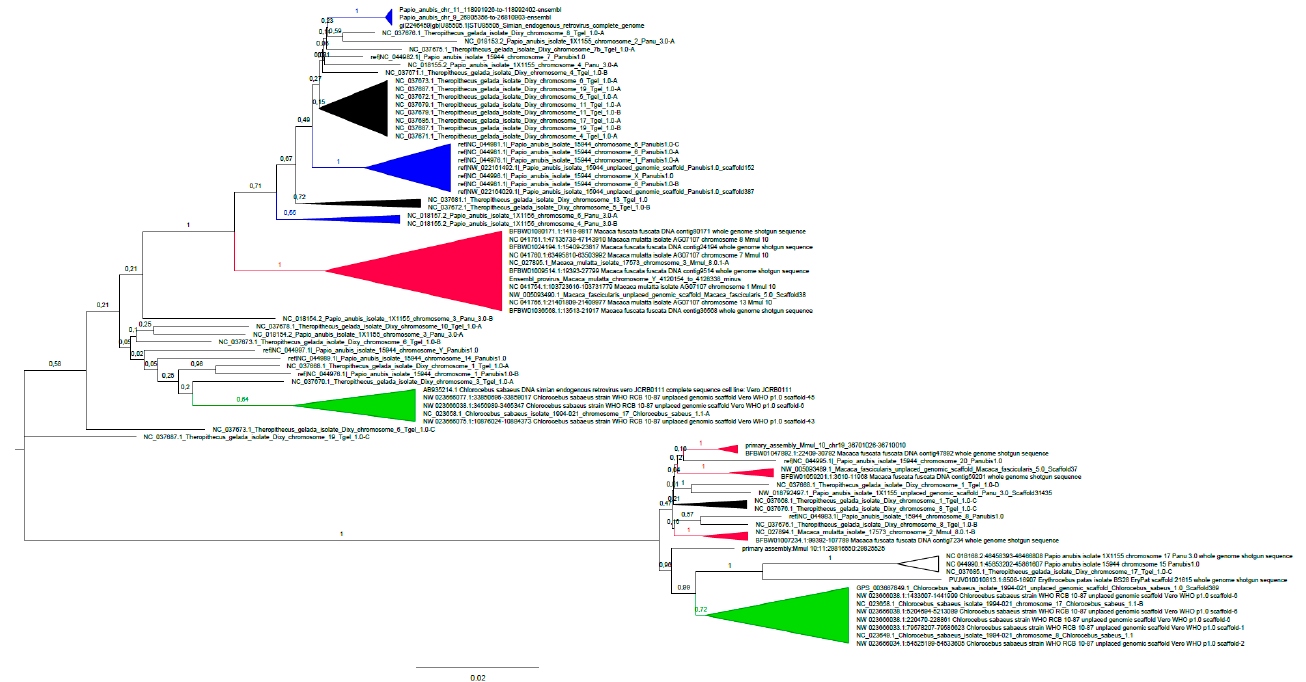
Figure 1. Phylogenetic analysis of 81 full-length Cer-SERV genomes. The evolutionary history was inferred by using the Maximum-Likelihood method and Hasegawa-Kishino-Yano model [12]. The tree with the highest log likelihood ( − 56214.44) is shown. The percentage of trees in which the associated taxa clustered together is shown next to the branches. There were a total of 8334 positions in the final dataset. Species-specific clusters have been collapsed for clarity and are indicated with colors ( Chlorocebus, green; Macaca, red; Papio, blue; Theropithecus, black). The shared integration on chromosome 17 is indicated by an open triangle. Although the clustering of the E. patas provirus suggests it is related to the shared chromosome 17-provirus, that integration site is empty in the E. patas genome. An enlarged image can be found as Figure